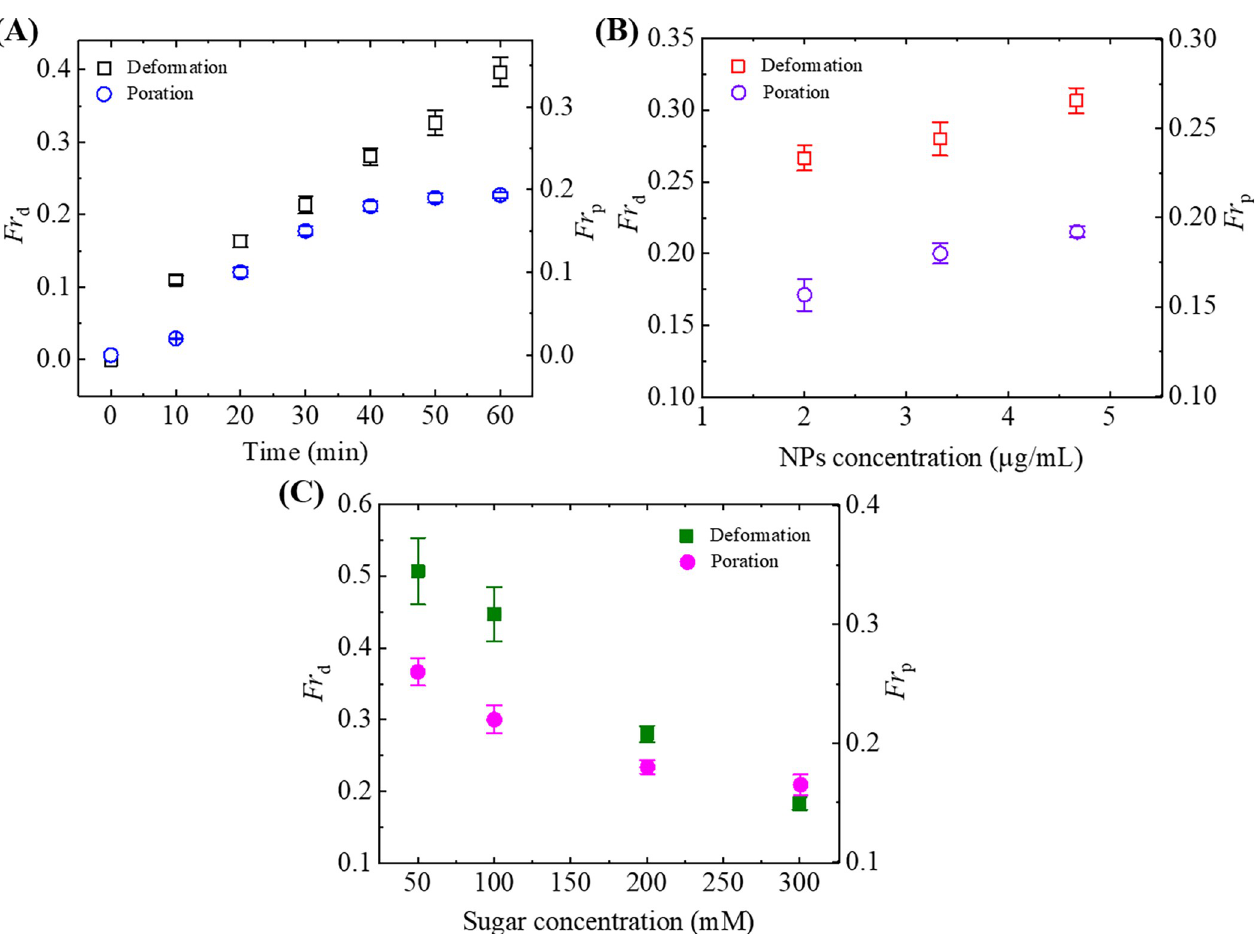
Fig 5. Fraction of deformed and pore formed 40%DOPG/60%DOPC-GUVs. (A) The time-dependent Fr d and Fr p under 3.33 μ g/mL NPs at 200 mM sugar concentration. (B) The NPs concentration-dependent Fr d and Fr p . (C) The sugar concentration-dependent Fr d and Fr p using 3.33 μ g/mL NPs at 40 min. The average values with standard deviations were obtained from 3 independent experiments containing 15–20 GUVs in each independent experiment.